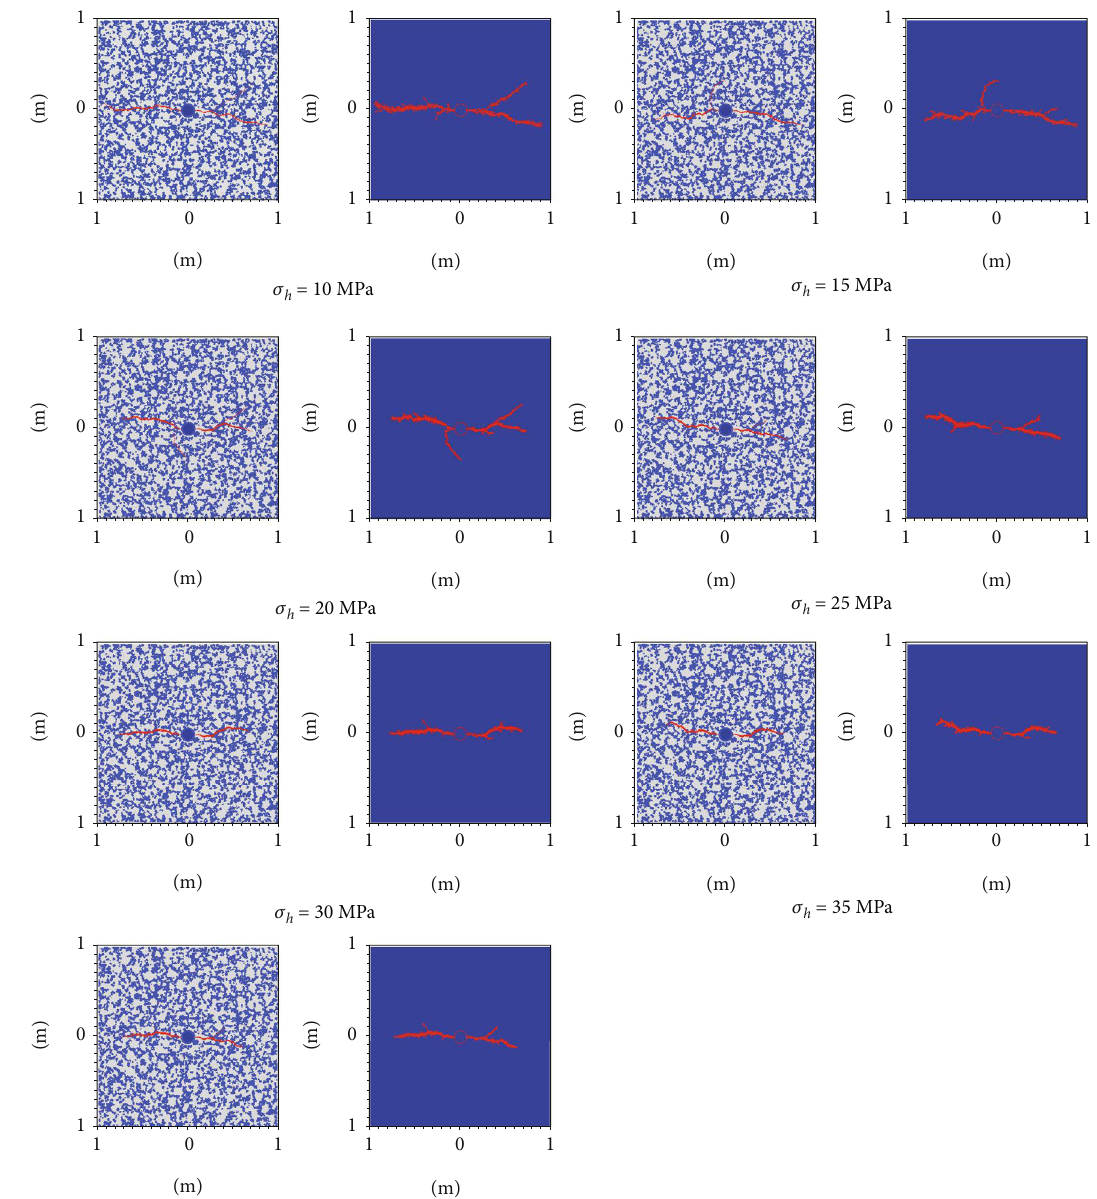
Figure 17: Geometric parameters of HF under di ff erent minimal horizontal